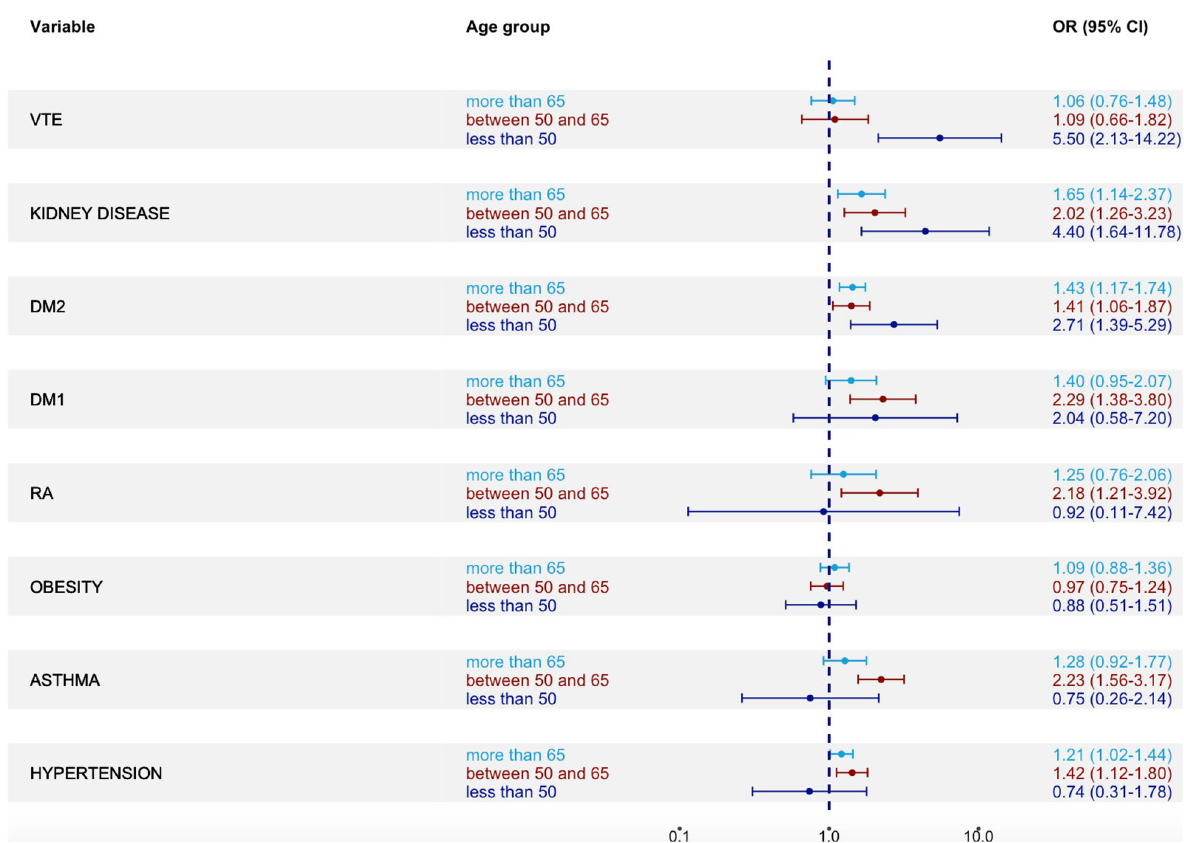
Fig. 5 Associations of co-morbidities and 90-day mortality (adjusted ORs with 95% CIs) in all three age groups. This adjusted model included co-variates of age and